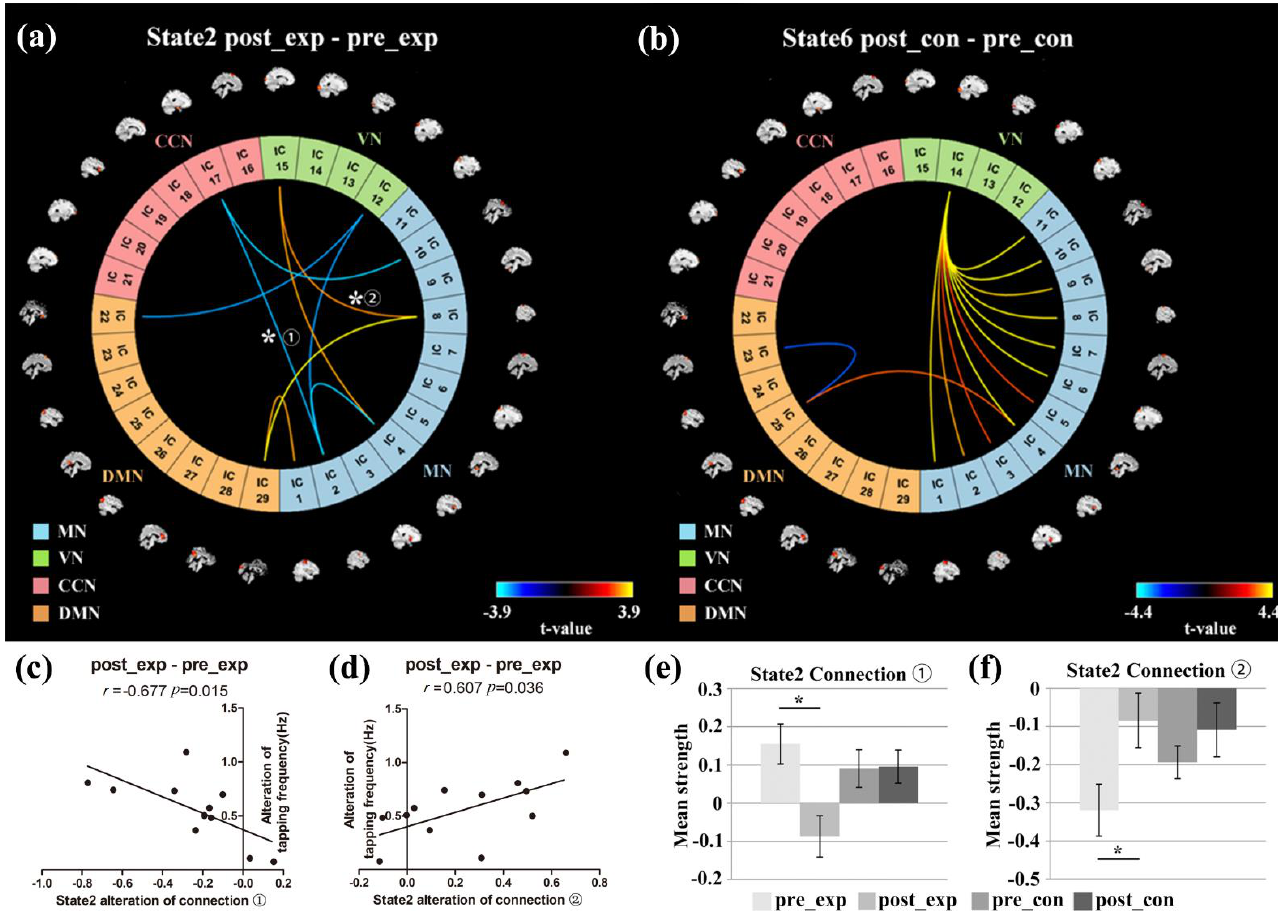
Figure 9. Significant connectivity differences in the target FC states for the experimental group and control group. ( a , b ) The connectives showing significant differences for the post-training minus the pre-training run in state 2 of the experimental group ( a ) and in state 6 of the control group ( b ), ( c ) the significant regression relationship between the alteration of the tapping frequency and the alteration of the connectivity of connection 1 for the experimental group after neurofeedback training, ( d ) the significant regression relationship between the alteration of the tapping frequency and the alteration of the connectivity of connection 2 for the experimental group after neurofeedback training, and ( e , f ) the mean connectivity strength of connection 1 ( e ) and connection 2 ( f ) for the pre-training and post-training runs of the two groups. Error bars represent the standard error (* p < 0.05).